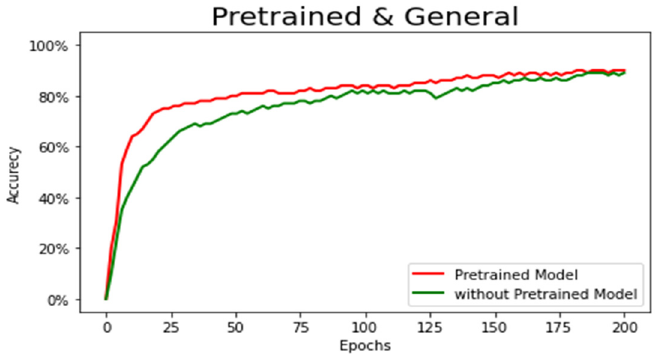
Figure 8. Comparison of our model with and without pretrained weights.